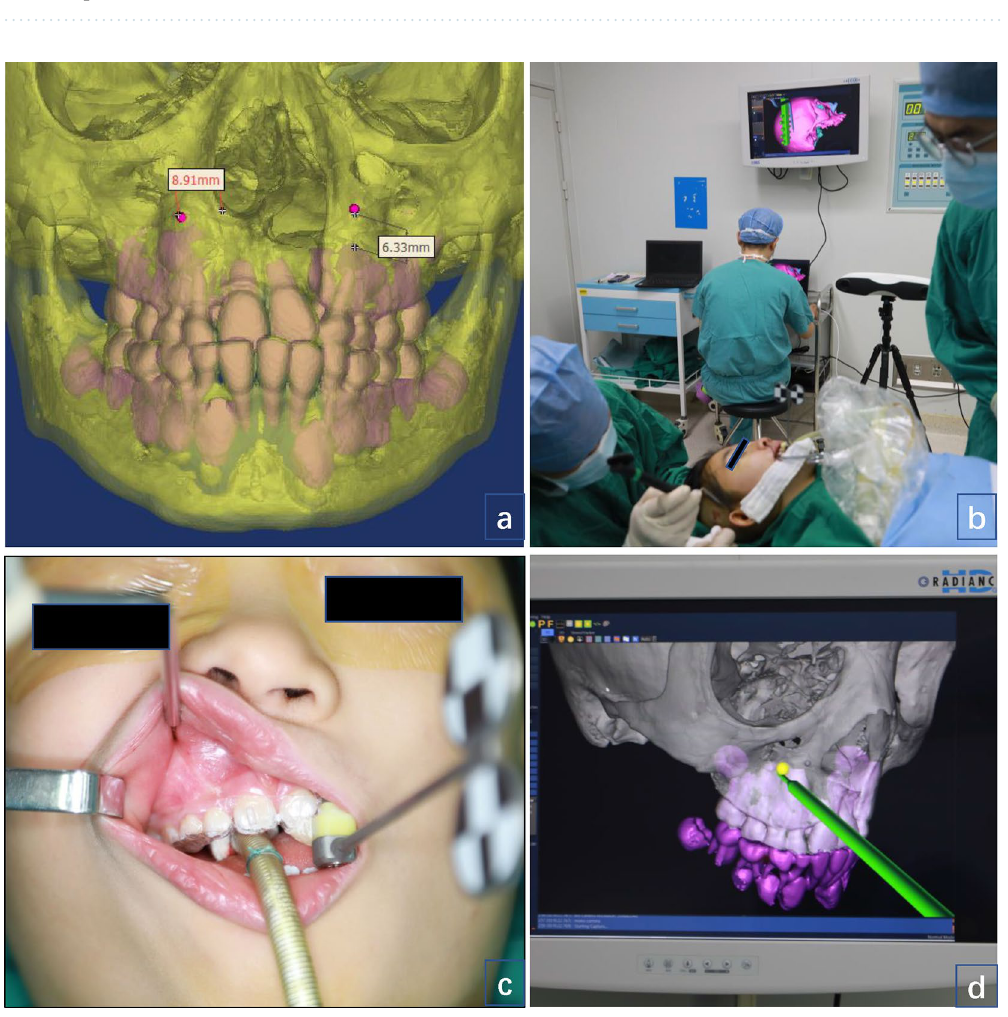
Figure 5. Illustrates the real-time process of guiding the surgery, dynamically based on this navigation system. ( a ) Preoperative design of traction hook placement points; ( b ) the position of the fixed screw punching can be reflected in the scalp projection point in real time through the OSNS intraoperatively; ( c , d ) With the assistance of the navigation system, the surgeon could observe the real-time location of the probe through the display screen without cutting the upper lip mucosa, separating the tissues to expose the